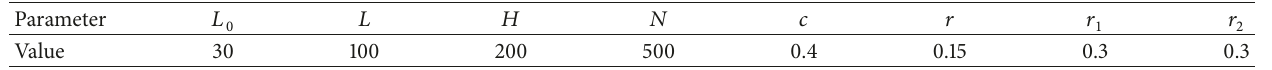
Table 3: Parameters setting in AMP.